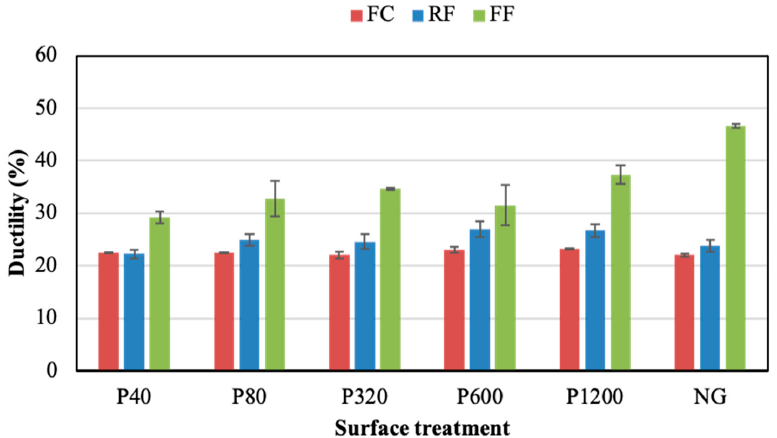
Figure 6. Cohesive failure percentage of adhesive joints under different surface treatments without adhesion promoter.